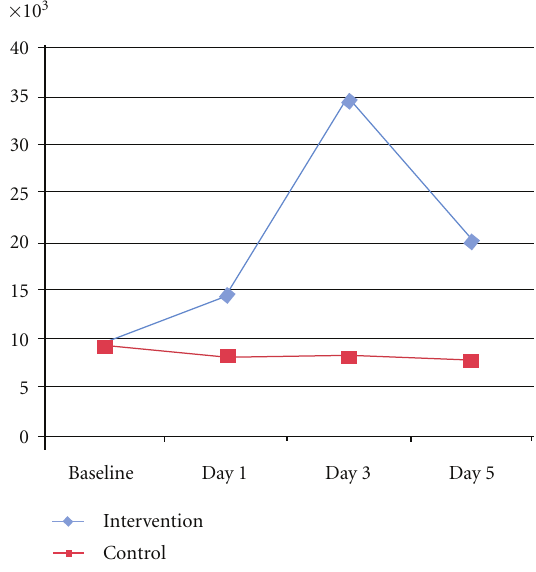
Figure 5: Mean Leukocyte count of intervention and control groups at Baseline, Day 1, Day 3, and Day